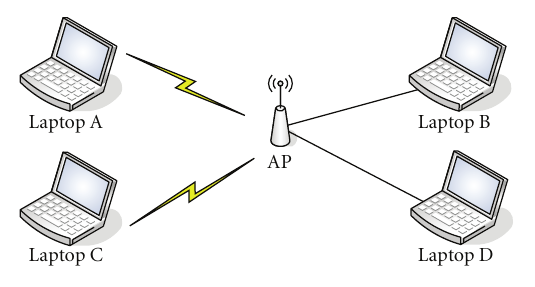
Figure 10: Test setup.